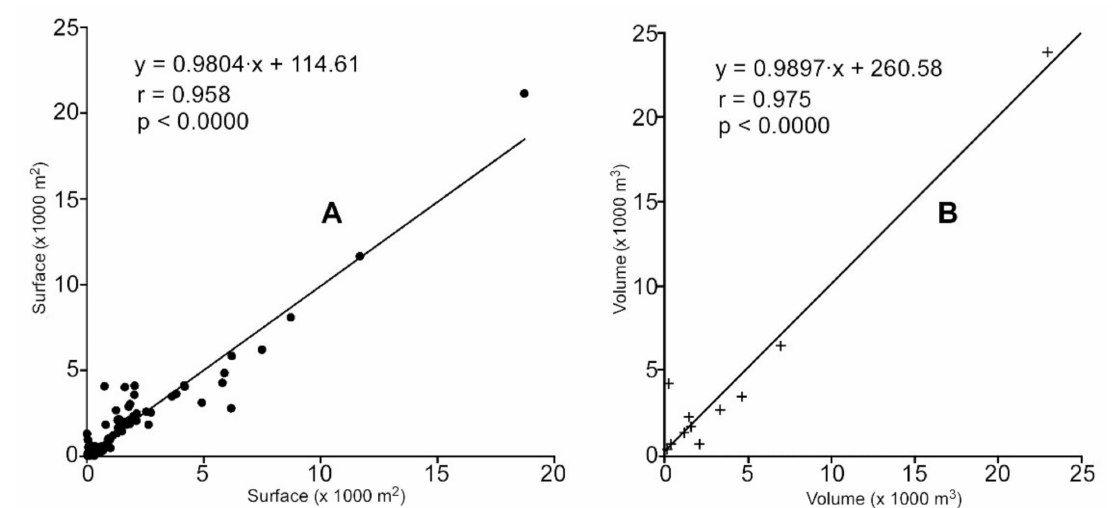
Figure 5. Agreement between two methods used defining ( A ) waterlogged surfaces and ( B ) volumes of water: for more detail, see the text. A statistically significant relationship between the two groups of variables analysed exists both in A and B for a confidence interval of